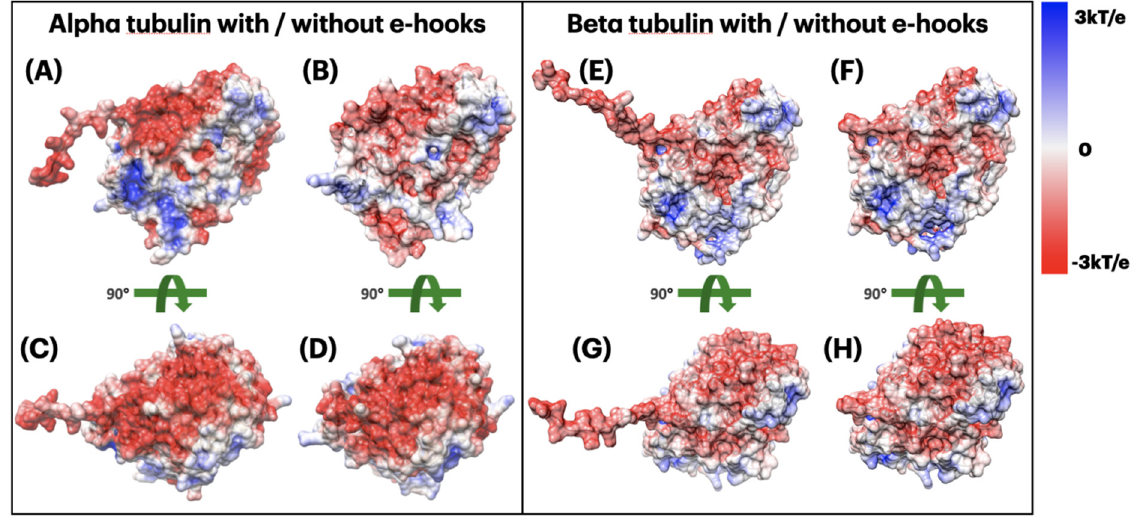
Figure 4. Electrostatic potential is colored on the surface of tubulins. ( A ) Alpha tubulin with E-hook (front view); ( B ) Alpha tubulin without E-hook (front view); ( C ) Alpha tubulin with E-hook (top view, interfacial side); ( D ) Alpha tubulin without E-hook (top view, interfacial side); ( E ) Beta tubulin with E-hook (front view); ( F ) Beta tubulin without E-hook (front view); ( G ) Beta tubulin with E-hook (top view, interfacial side); ( H ) Beta tubulin without E-hook (top view, interfacial side). Color scale: − 3.0 to 3.0 kT/e (red to blue).